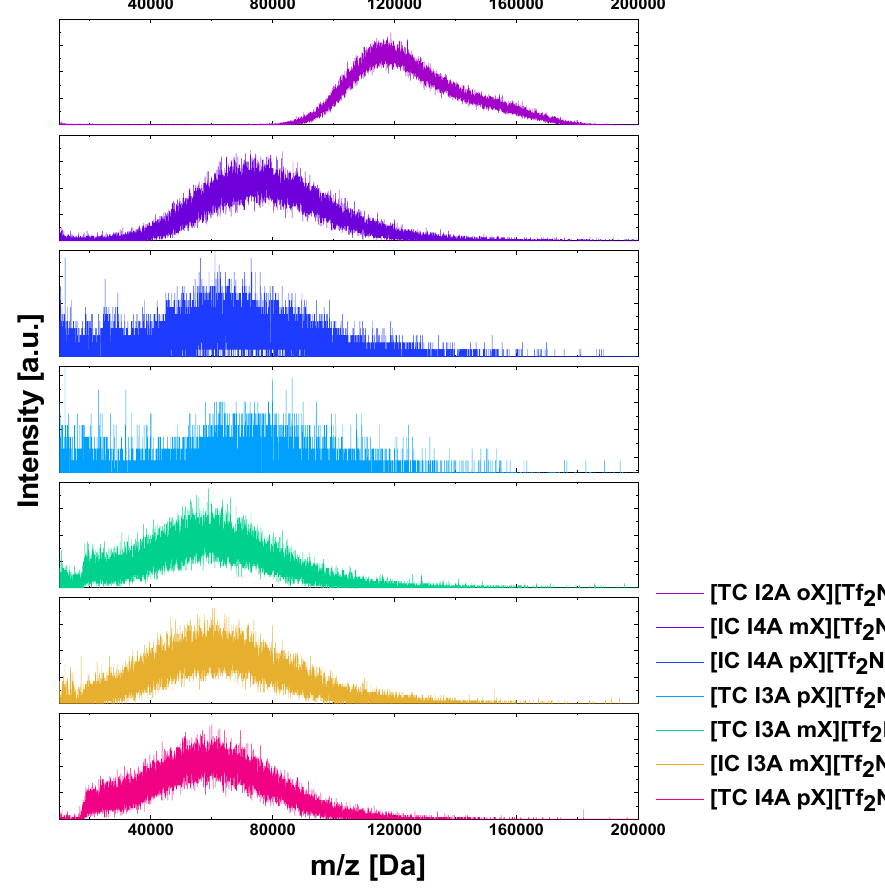
Figure 2. MALDI-TOF MS data for all neat PA-ionene derivatives.